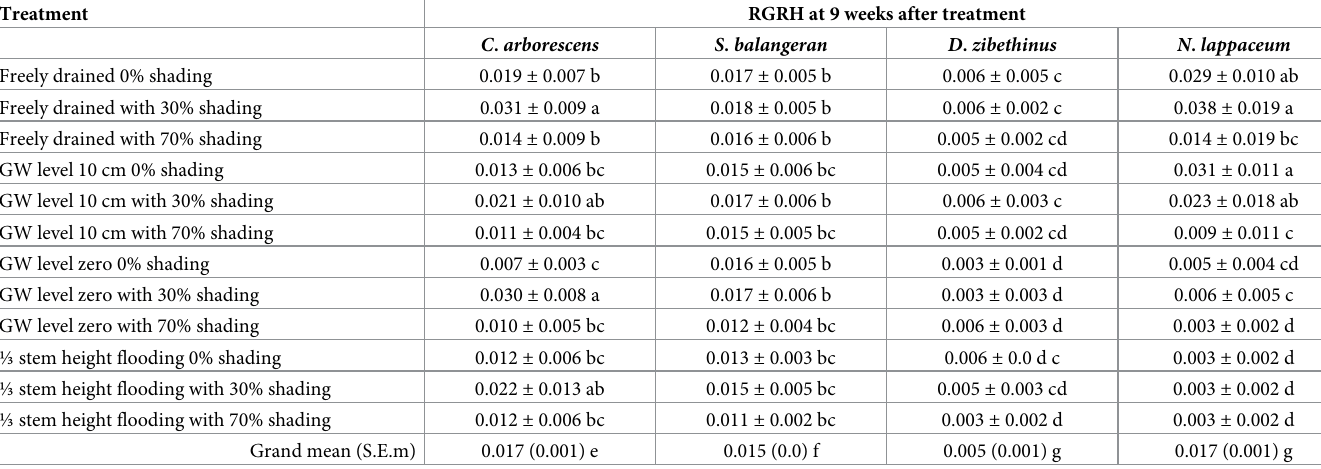
Table 4. RGRH of C . arborescens , S . balangeran , D . zibethinus and N . lappaceum at 9 weeks after planting in the shading and inundation treatments. Treatment